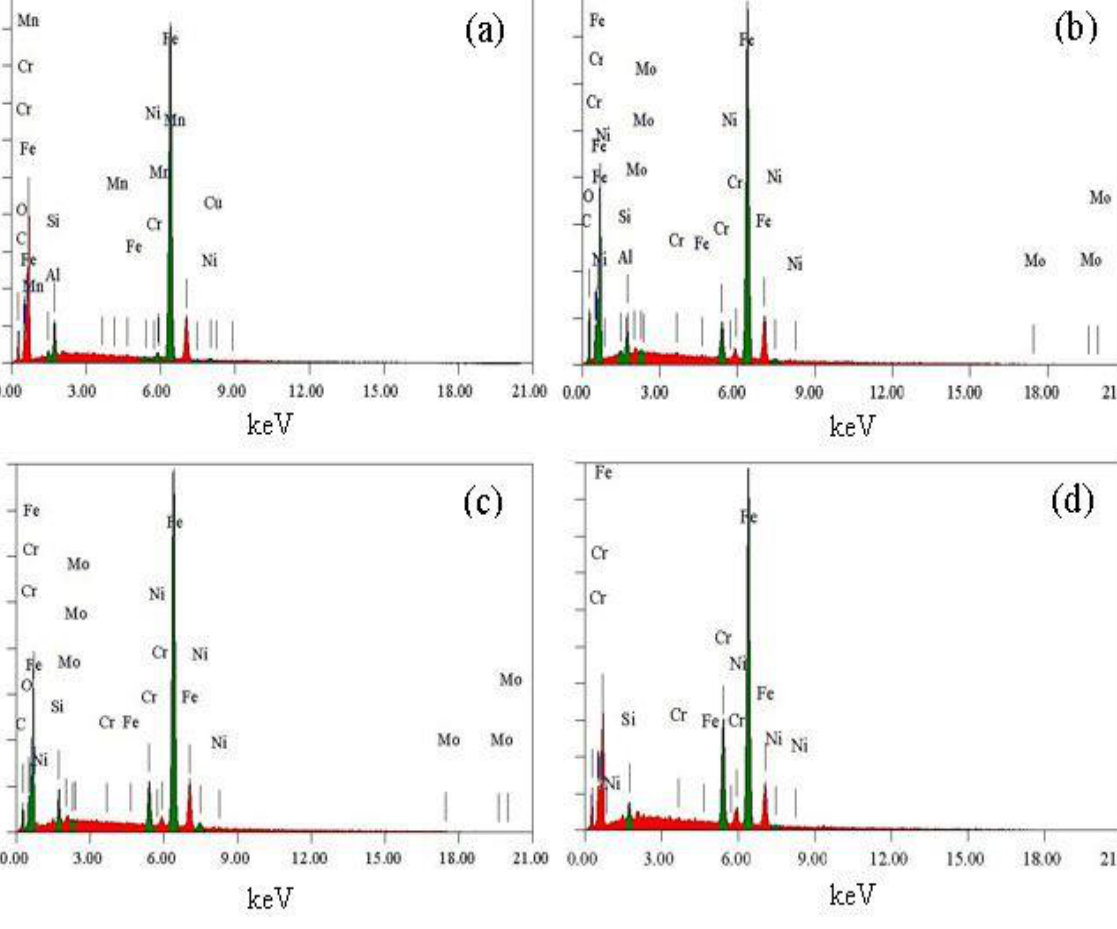
Figure 10: Energy Dispersive X-Ray (EDX) analysis to quantify the deposition of atom on the surface. (a) Sample